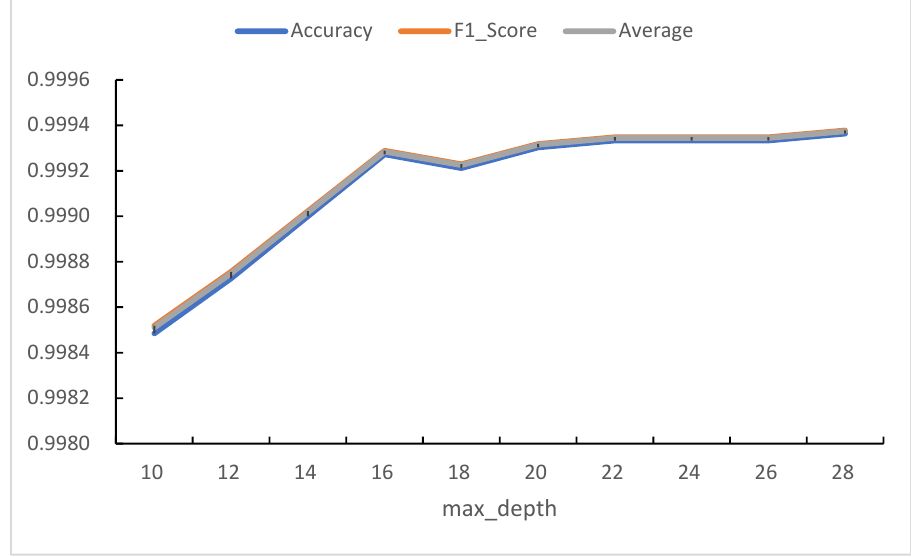
Figure 15. max_depth optimizes Accuracy, F1_Score, and Average.